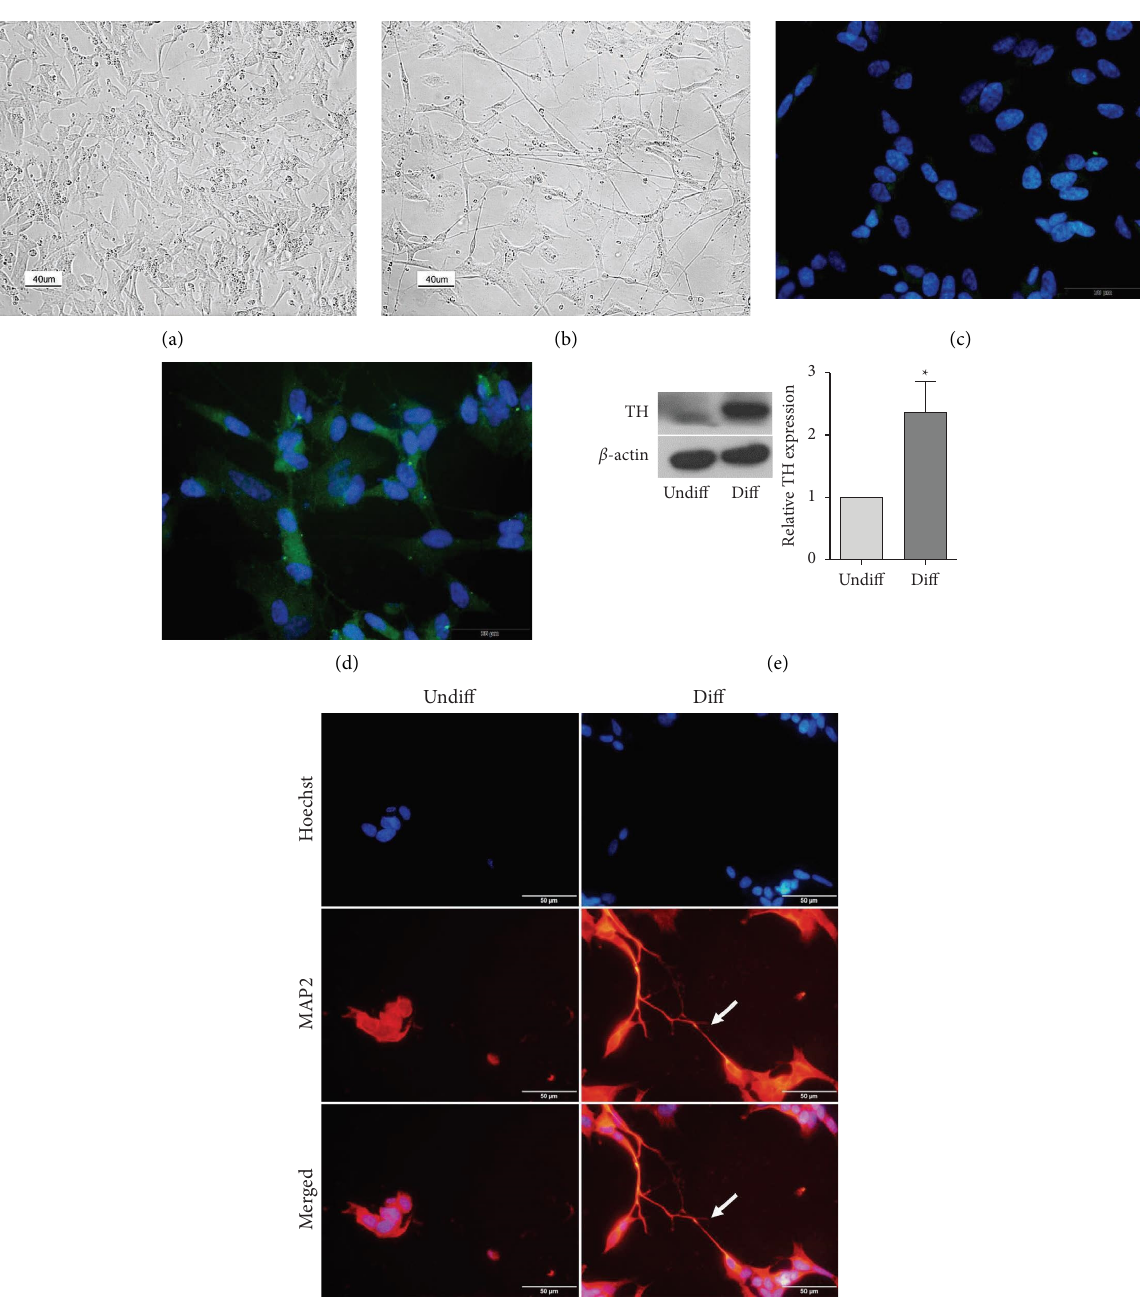
Figure 1: Diferentiation of SH-SY5Y cells into a neuronal phenotype. SH-SY5Y cells were treated with 10 μ M RA for 10days for neuronal diferentiation. Inverted epifuorescence microscope revealed morphology of (a) undiferentiated and (b) diferentiated cells. Scale bar � 40 μ m. Expression of TH in (c) undiferentiated and (d) diferentiated cells was visualized using immunofuorescence staining: Hoechst nuclear staining in blue and TH in green. Scale bar � 50 μ m. (e) Western blotting analysis and quantifcation of TH in un- diferentiated and diferentiated cells expressed as mean ± SEM ( n � 3). ∗ p < 0 . 05 by student’s t -test. (f) Expression of MAP2 in 5-day diferentiated cells using immunofuorescence staining: Hoechst nuclear staining in blue and MAP2 in red. Scale bar � 40 μ m. White arrows indicate neurite